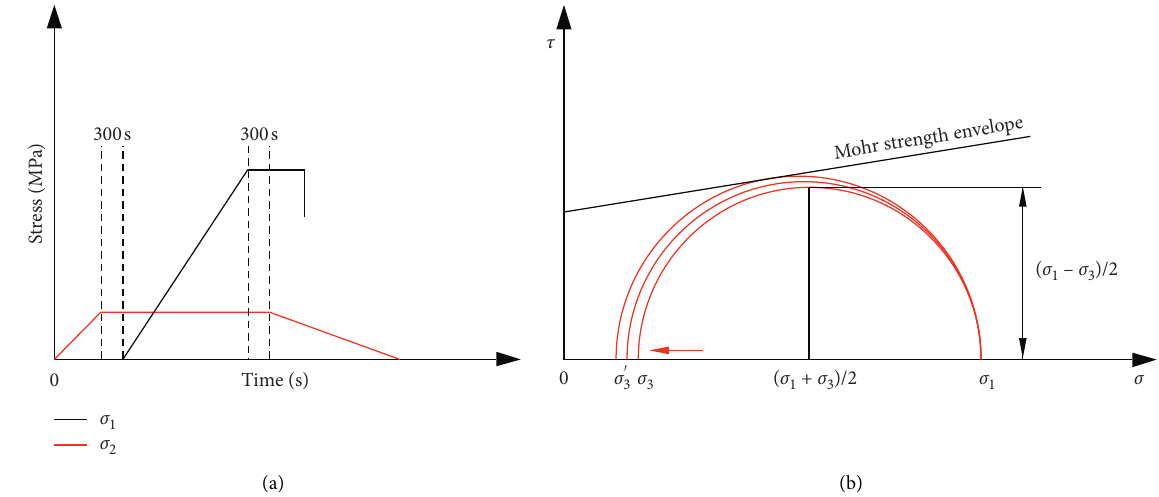
Figure 3: Experimental process of sandstone unloading. (a) Experimental stress path (b) Failure principle of rock samples.